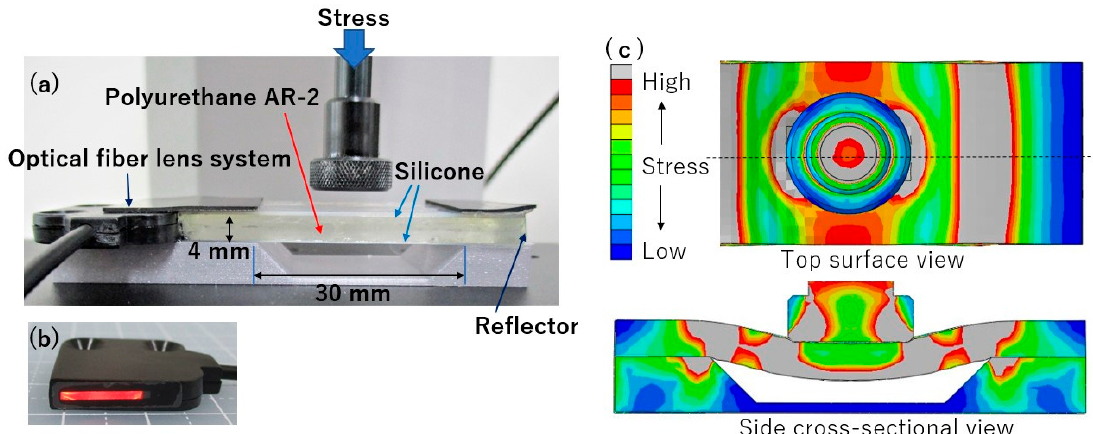
Figure 2. Bending elasticity measurement device and internal stress simulation (at 10 N load): ( a ) photographs of bending elasticity measurement device and ( b ) optical fiber lens head, and ( c ) simulation results of internal stress at 10 N load.